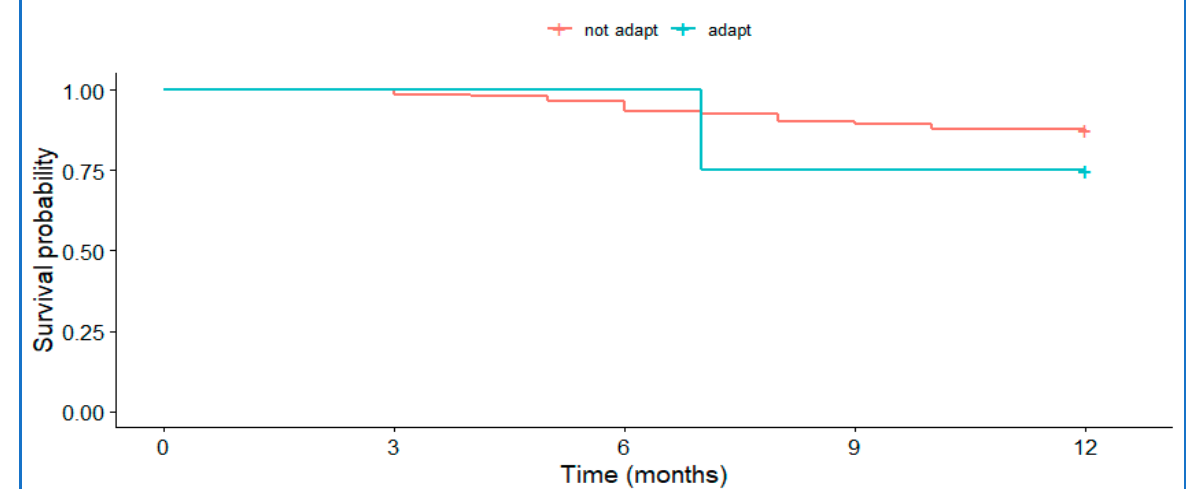
Figure 2. Adaptation by debt restructuring (Ad10).